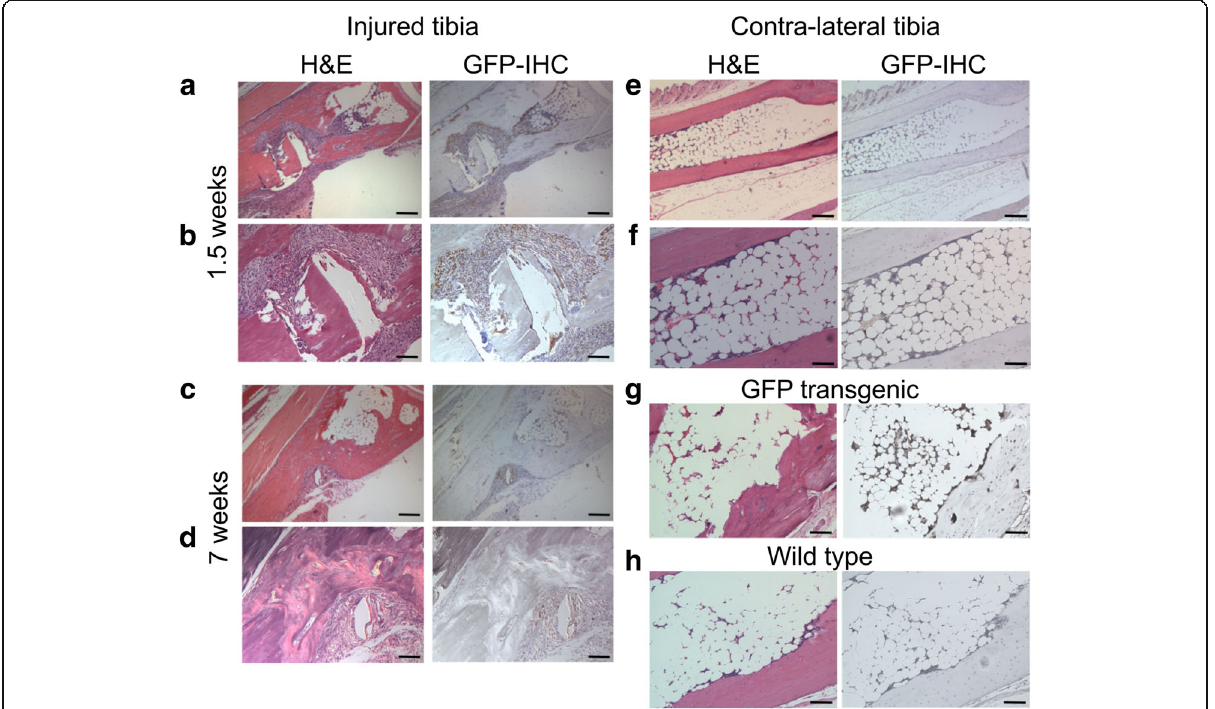
Fig. 6 GFP + donor cells are detected in the bone fracture. a , b BM cells from GFP transgenic mice were transferred to wild-type mice immediately after tibial fracture and 1.5 weeks later, the fractured tibia section and corresponding contralateral tibia section were harvested. Tissues slices were stained with H&E and with GFP-IHC. Microscopic images of fractured tibia indicated that the fractured bone was surrounded by inflammatory tissue ( a , b , left, H&E) and GFP + donor cells were engrafted around the fracture ( a , b , right, GFP-IHC). c , d Tissue sections created at 7 weeks following the bone marrow cell transfer indicated callus formation with GFP + cells in the surrounding soft-tissue (left: H&E, right: GFP-IHC). e , f Contralateral non-fractured tibia at 1.5 weeks after the cell transfer is shown. g , h Tibia from a GFP + ( g ) and a wild-type ( h ) mice are shown as controls. Scale bar indicates 200 μ m in ( a , c ) and ( e ), and 100 μ m in ( b , d , f , g ) and ( h